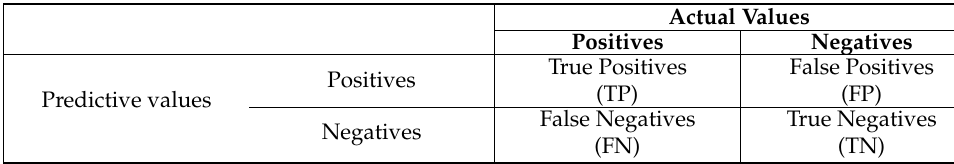
Table 2. Confusion matrix for classification.